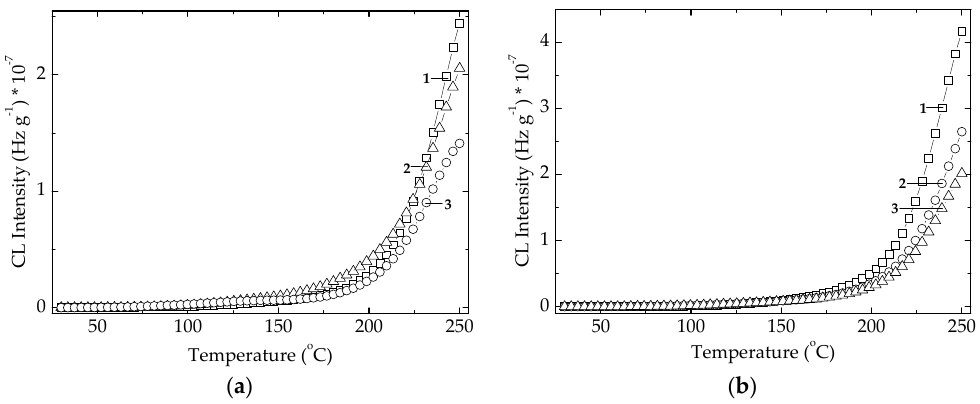
Figure 6. Non-isothermal CL spectra recorded on microalgal powders at three irradiated doses. ( a ) Chlorella vulgaris ; ( b ) Spirulina platensis . (1) 0 kGy; (2) 25 kGy; (3) 100 kGy. Heating rate: 10 ◦ C min − 1